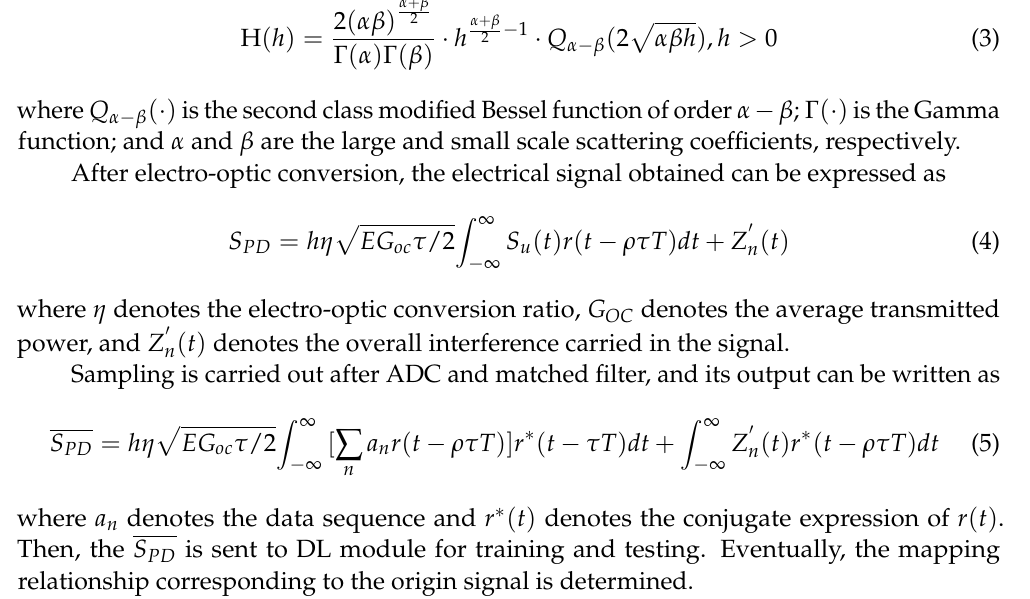
h t Figure 3. Diagram of the LSTM network. LSTM can prevent the gradient disappearance problem by defining “gate” opera- tions (i.e.,